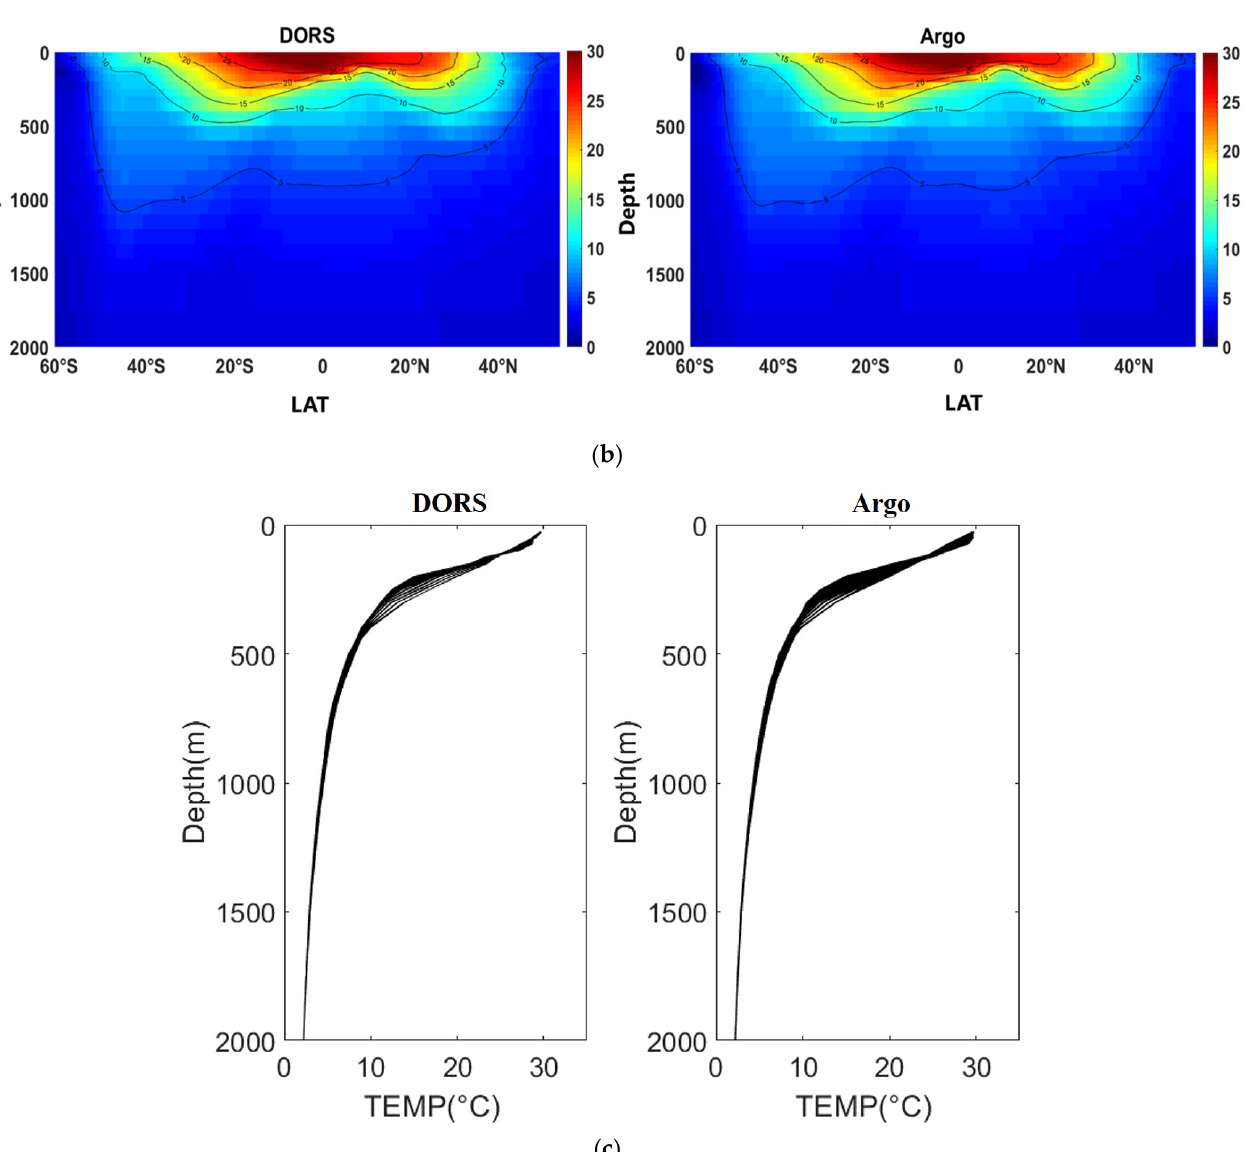
Figure 9. ( a ) Spatial distribution of sea surface temperature (SST) in the global ocean in January 2016. A meridional profile A (longitude of 160°W) and a rectangular profile B were intercepted in the figure to analyze the vertical variation of ST. ( b ) The meridional vertical distribution of Argo ST and DORS ST in January 2016 where the longitude is 160°W. ( c ) Vertical profile of all grid points in rectangular area B for DORS ST and Argo ST in January 2016.